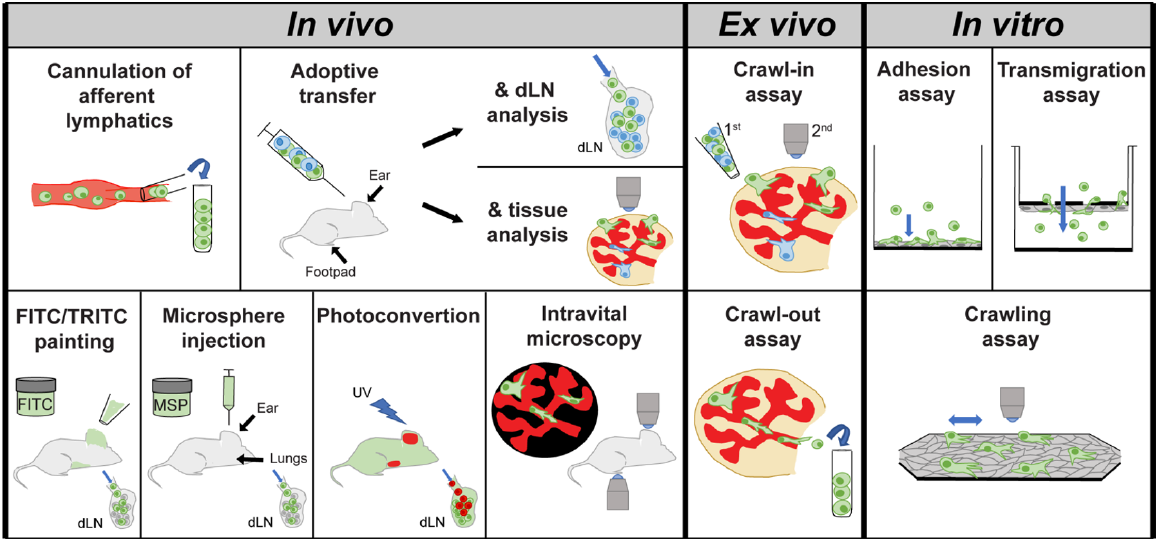
Figure 2. Schematic depiction of current in vivo and ex vivo or in vitro methods used to study leukocyte migration into and within afferent lymphatics. Detailed explanations and references to studies employing these methods are provided in the text of Section